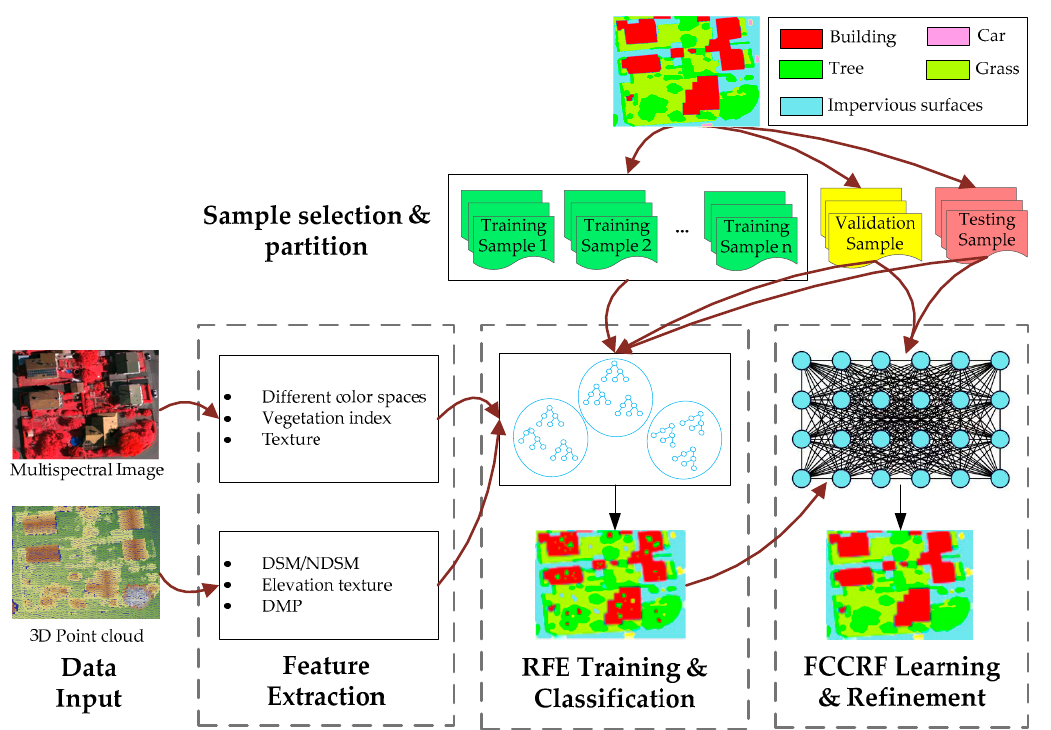
Figure 1. Pipeline of the proposed classification method.